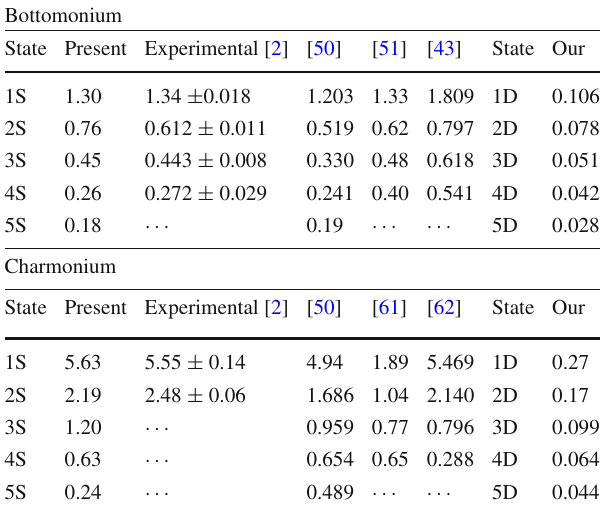
Table 9 Leptonic decay width (in keV) of the S-wave and D-wave bottomonium and charmonium states Bottomonium